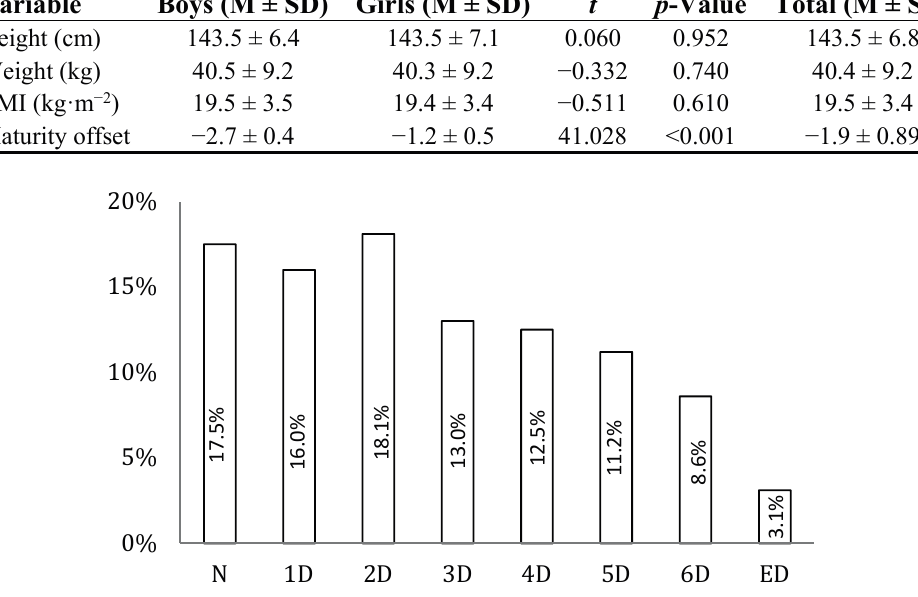
Figure 1. Percentage of children meeting the 60 min of MVPA guidelines by the number of days per week (N = never, 1D = 1 day, 2D = 2 days, 3D = 3 days, 4D = 4 days, 5D = 5 days, 6D = 6 days, ED = every